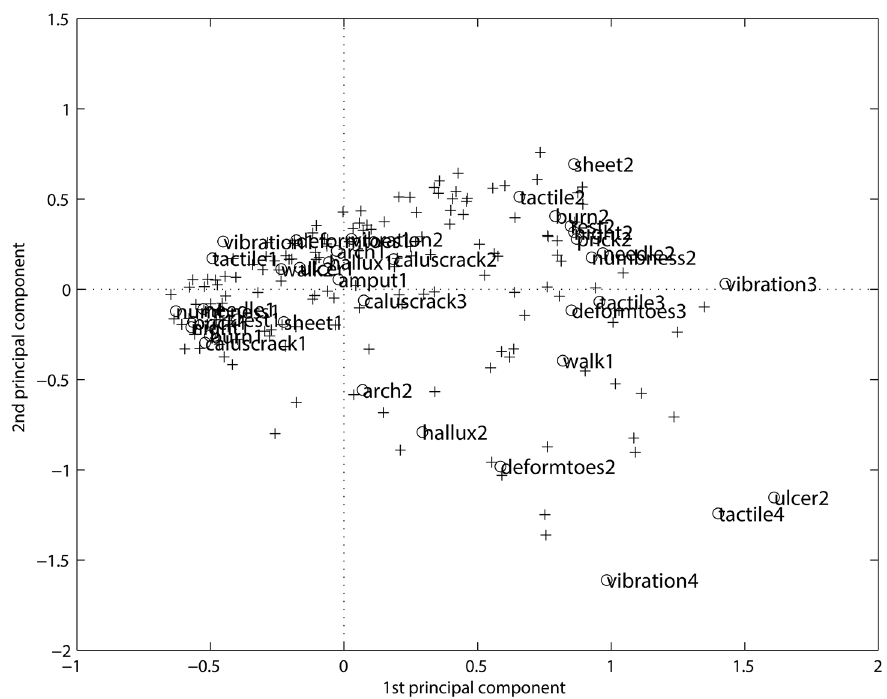
Fig 1. The MCA representation. The projection on the first 2 axes (29%) and 2 (17%) represents only 46% of the explained inertia from Table 2. The ‘ + ’ input is for the rows (i.e. patients) and the ‘ o ’ input is for the columns (i.e.